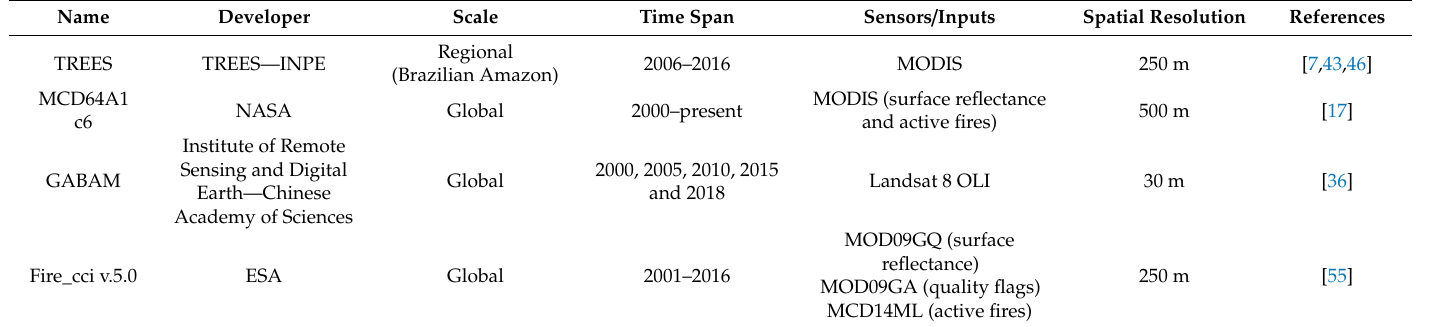
Table 1. Specifications of the burned area products to be compared.